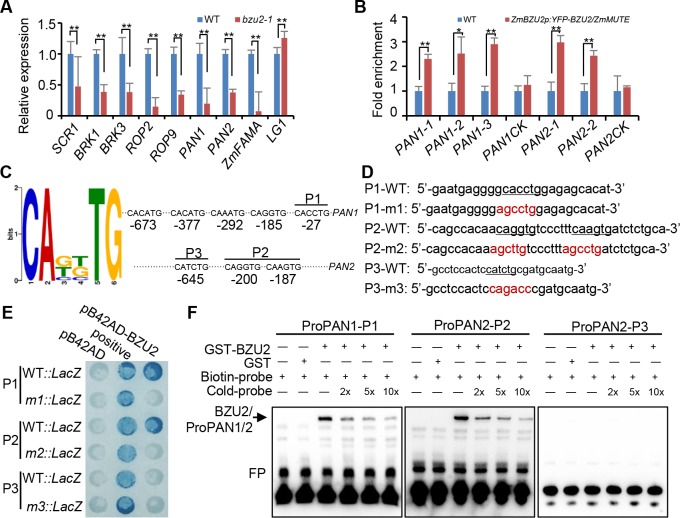
BZU2/ZmMUTE binds to the E-box motifs located in the PAN1 and PAN2 promoters.(A) RT-qPCR analysis of the expression of the genes associated with stomatal development indicates repression of transcription in bzu2-1 mutant plants. RNA was taken from samples excised up to ~1.5 cm from the base of second and third leaves. RT-qPCR values are expressed as the mean ± SD compared to that of the internal control (ZmUbiquitin 2). Error bars indicate SD, n = 3, Student’s t test, **P < 0.01. Assays were done in triplicate. (B) ChIP-qPCR results indicating that the promoter fragments of PAN1and PAN2, can be amplified from the immunoprecipitates pulled down by the anti-GFP antibody. The sequences used for ChIP-qPCR contain the E-box cis-elements located within the PAN1 and PAN2 promoters. Second and third leaf base sections (~1.5 cm) of 8-day-old seedlings were harvested for the chromatin immunoprecipitation (ChIP) experiments. Sequence from regions of the PAN1 and PAN2 promoters lacking the E-box cis-elements were used as controls. Error bars indicate SD, n = 3, Student’s t test, **P<0.01. (C) The E-box motifs in the promoters of PAN1 and PAN2. The bHLH transcription factor binding the cis-element consensus sequence (E-box) and their locations in the promoters of PAN1 and PAN2 (-750 - -1). The E-box (6 bp) motif logo was produced by MEME based on previously studied motifs. The relative position of E-box cis-elements in the promoters of PAN1 and PAN2 as detected by ChIP-qPCR. (D) The DNA fragments used for yeast one-hybrid and EMSA assays. The E-box is underlined, and the mutated sequences are highlighted in red. (E) Yeast one-hybrid assays showing BZU2/ZmMUTE binding to the E-box motifs present in the PAN1 and PAN2 promoters. (F) EMSA assays showing specific binding of BZU2/ZmMUTE to the E-box motifs in the PAN1 and PAN2 promoters. EMSA was performed with probes that were biotin-labeled (biotin probe) or unlabeled (cold probe). E-box-containing DNA fragments (top panel) and recombinant BZU2/ZmMUTE protein; specific combinations are shown above the autoradiograph. Unlabeled fragments were added gradually in 2-, 5- or 10- fold excess, as indicated.